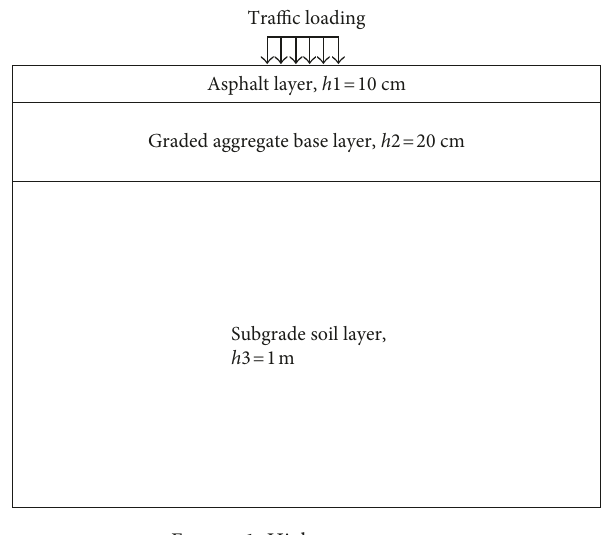
Figure 1: Highway structure.